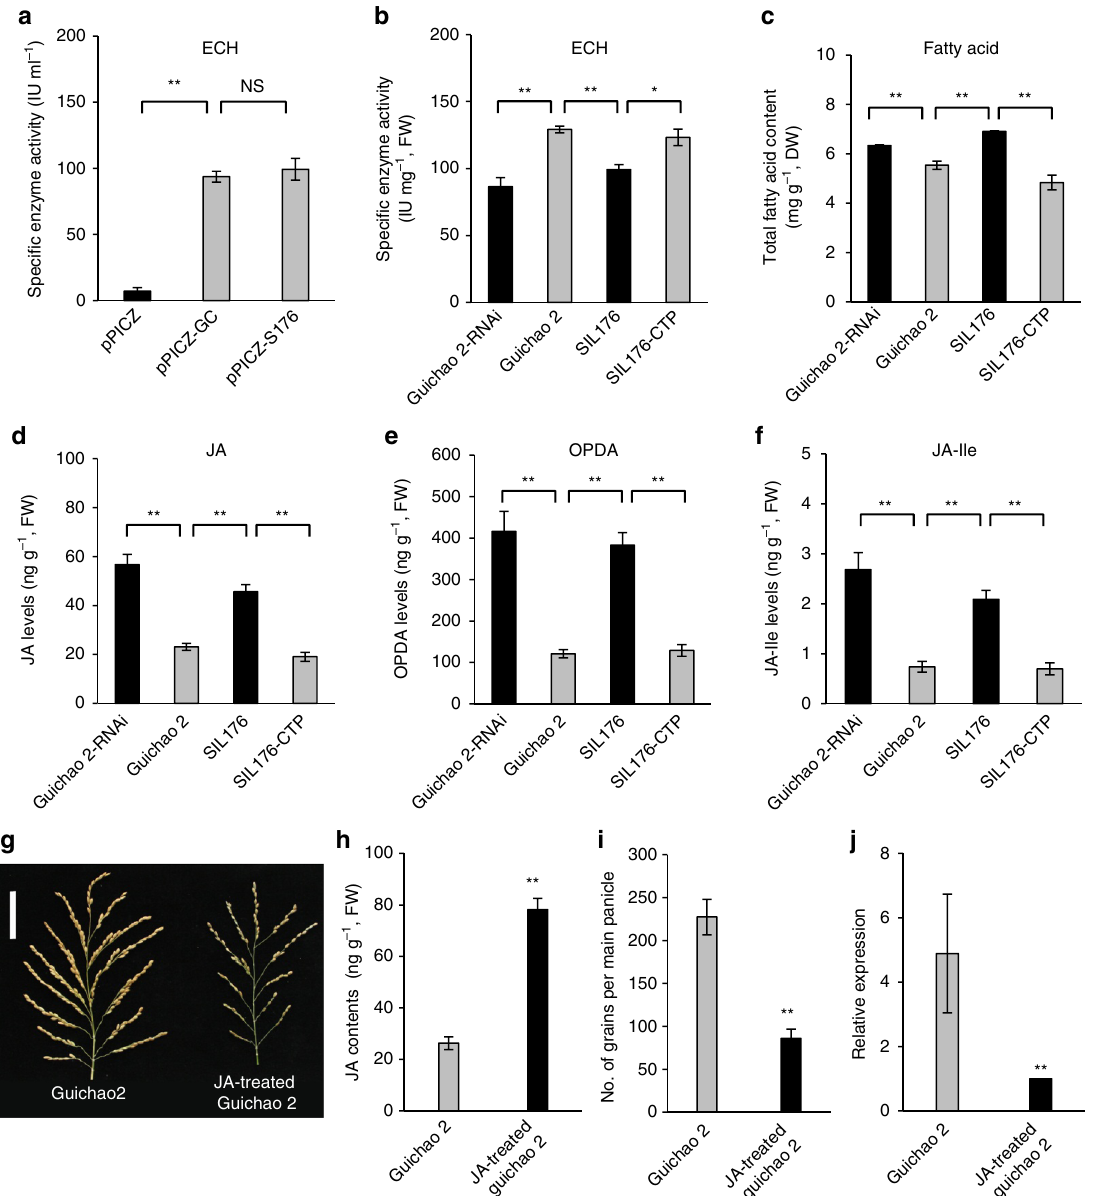
Fig. 5 Functional analysis of NOG1 . a ECH enzymatic activity assays of NOG1/nog1 and 6×His fusion protein by eukaryotic expression in Pichia yeast. The empty pPICZ-C vector plasmid was transfected as control (pPICZ), and pPICZ-GC and pPICZ-S176 were transfected by NOG1 and nog1 , respectively ( n = 10). b Enzymatic activity assays of ECH in young panicles among Guichao 2, SIL176, and transgenic plants ( n = 10). c Comparison of the total fatty acid content in young panicles among Guichao 2, SIL176, and transgenic plants ( n = 3). d – f Comparison of JA, OPDA, and JA-Ile levels in young panicles among Guichao 2, SIL176, and transgenic plants ( n = 10). g Main panicle of Guichao 2 and JA-treated Guichao 2. Scale bars, 5 cm. h , i Comparison of JA contents and the number of grains per main panicle between Guichao 2 and JA-treated Guichao 2 ( n = 10). j Comparison of NOG1 expression levels between Guichao 2 and JA-treated Guichao 2 ( n = 3). Data are means, with error bars showing SEM (two-tailed Student ’ s t test; ** P < 0.01; * P < 0.05; NS, P >